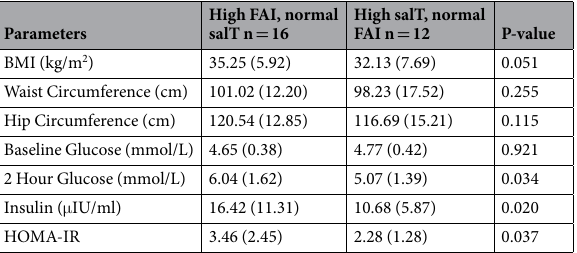
(Figure 2). The areas under the ROC curves showed no significant differences between androgen markers in pre- dicting PCOS, although the trend was for FAI (0.79) and salT (0.76) to be better than serum T, salA, serum A and the salT:salA ratio (0.68, 0.65, 0.66, and 0.65 respectively). As individual tests, an age and BMI adjusted multiple logistic regression suggested salT (OR = 1.074; 95% CI 1.017–1.133; p = 0.010) to be the better predictive measure than FAI (OR = 1.236; 95% CI 0.982–1.556; p = 0.072) (Table 4). salT (p = 0.010) and FAI (p = 0.041) were both significantly individually superior to serum T (p > 0.200) (Tables 5 and 6, respectively) in predicting PCOS.